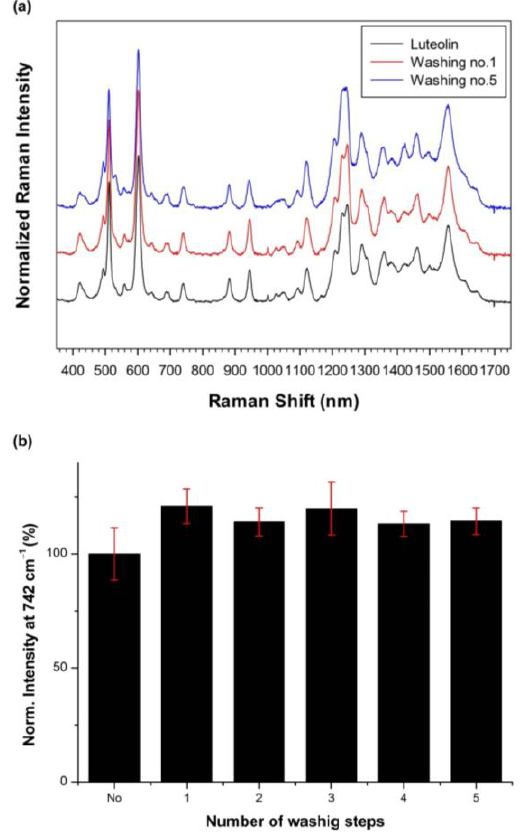
Figure 5. ( a ) Raman spectra and ( b ) normalized intensities of Lut captured by SiO 2 @Ag@Et-β-CD NPs at 742 cm −1 after washing with ethanol (Lut concentration, 10 −4 M).